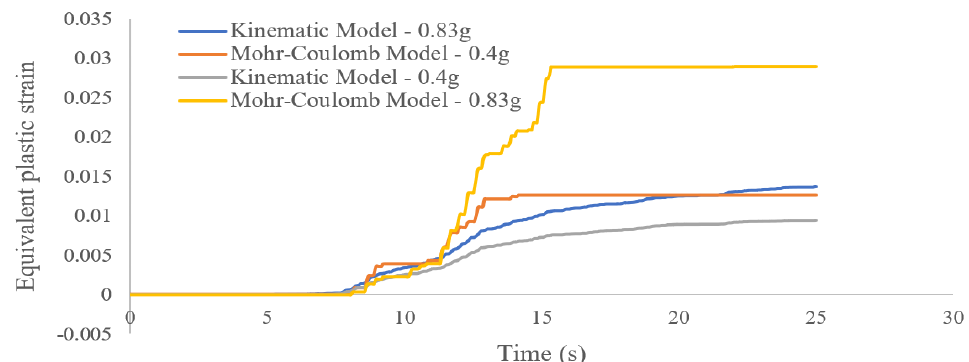
Figure 16. Equivalent plastic strain for a soil node above the tunnel crown.